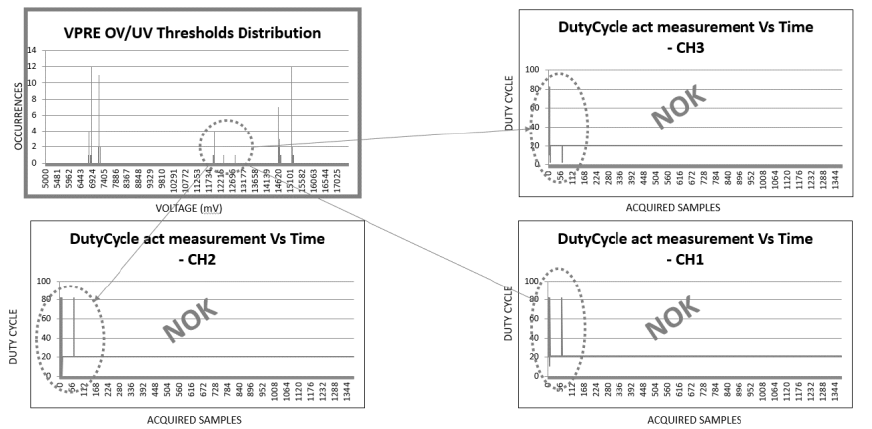
Figure 12. Correlating the anomalies to other